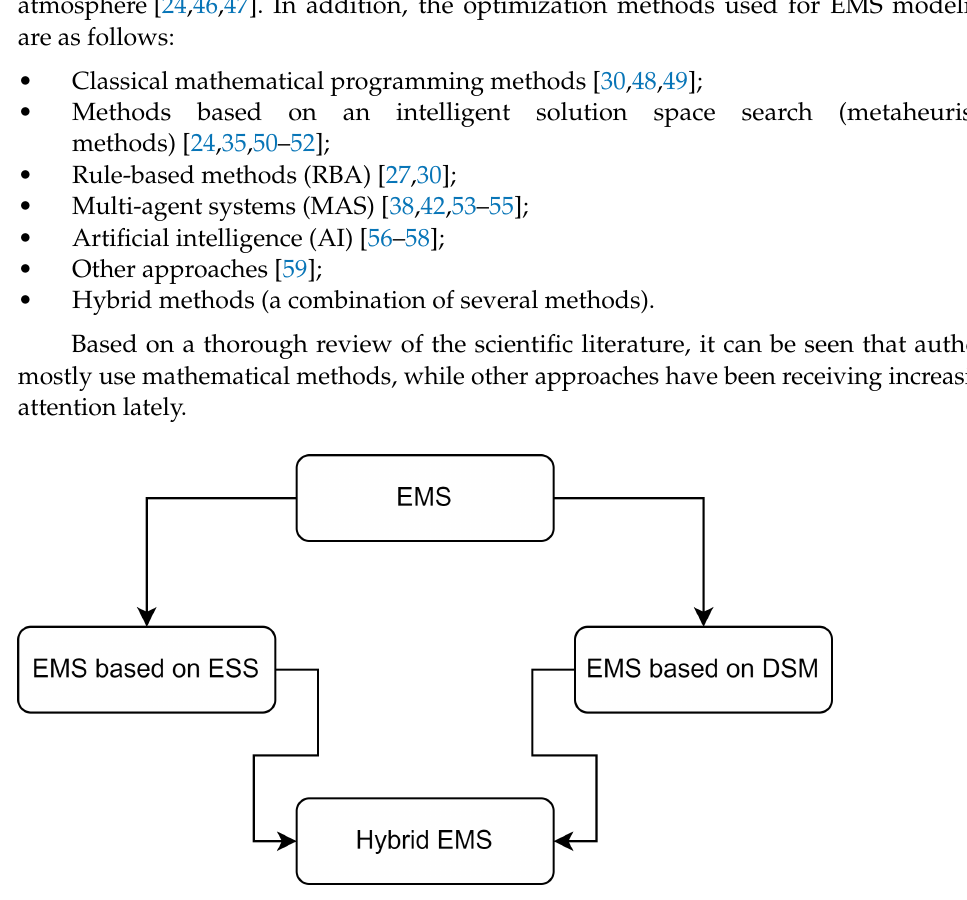
Figure 1. Classification of EMS in the scientific